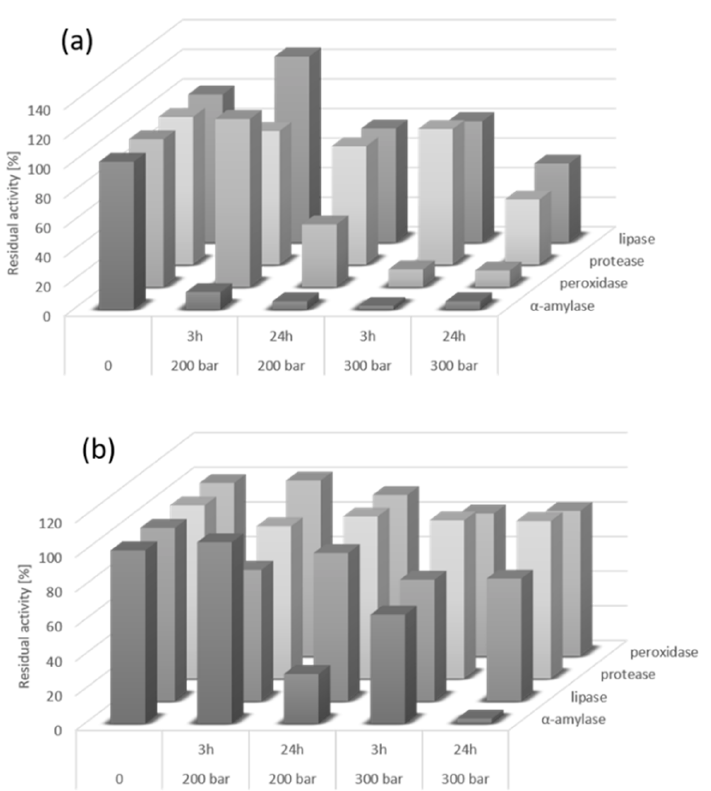
Figure 2. Determination of native enzymes’ ( a ) and wheat flour enzymes’ ( b ) activity after treatment at different scCO 2 conditions (35 °C). The value of the untreated enzyme was set to 100%.